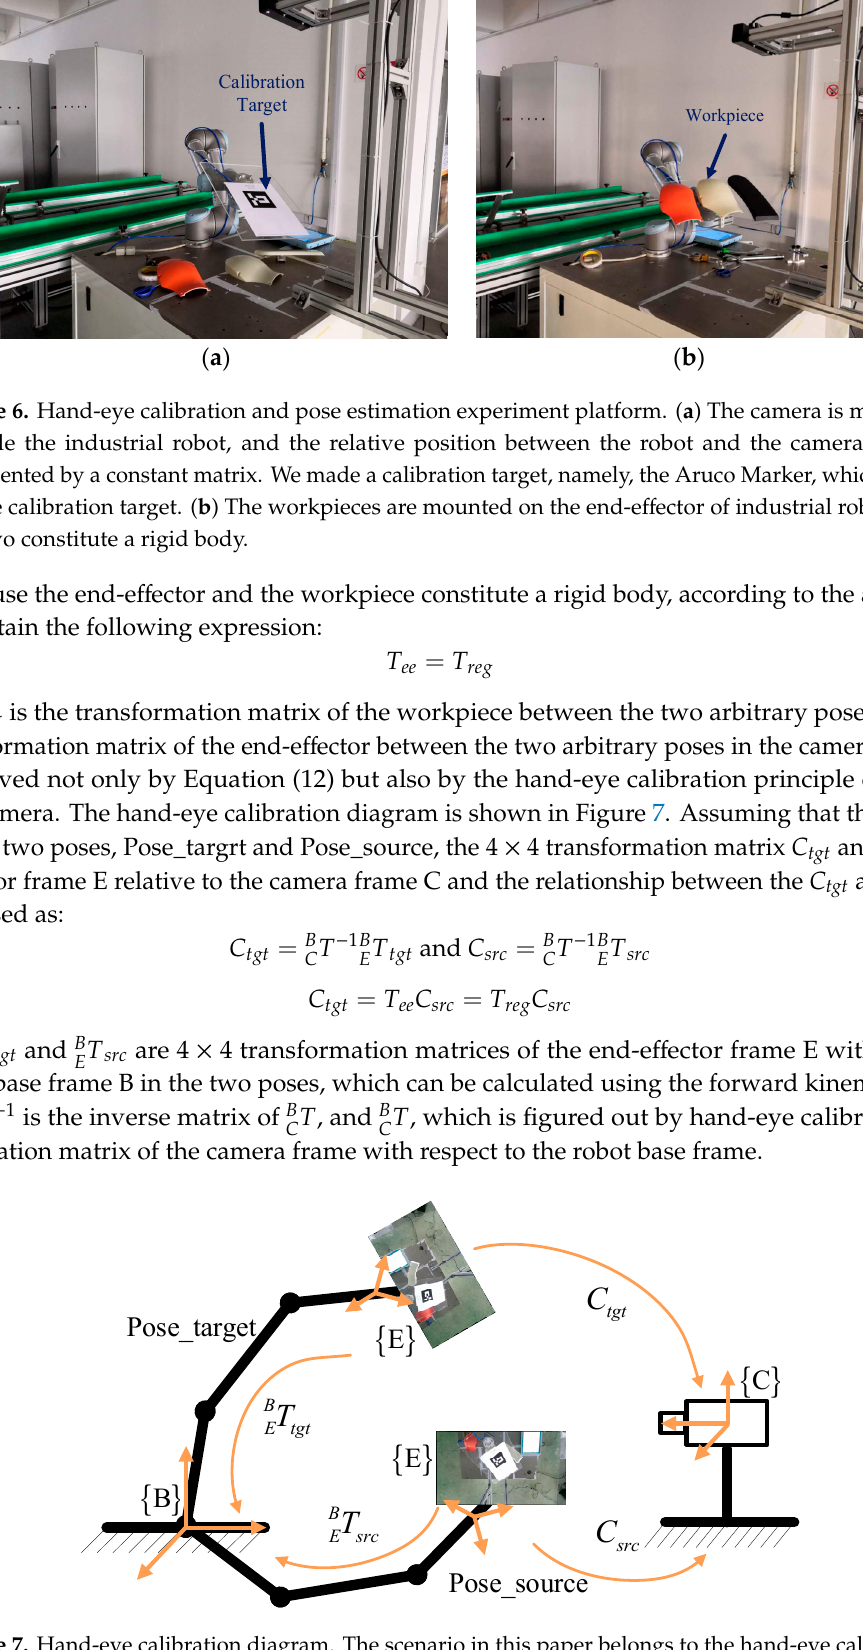
problem, where the camera and the robot base are relatively fixed.